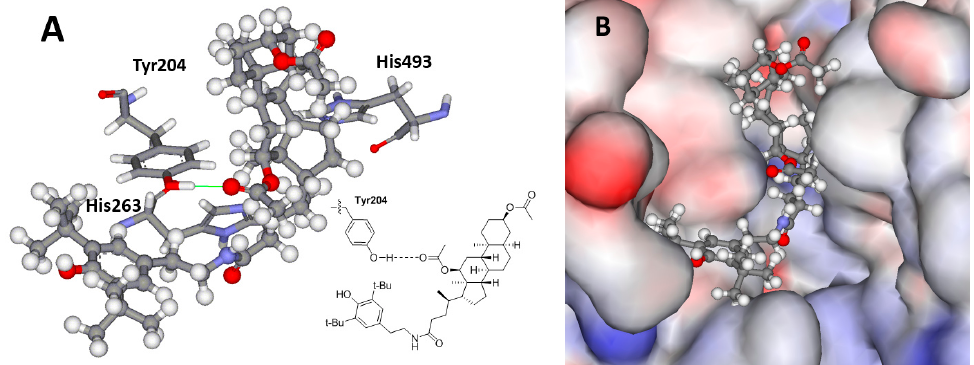
Figure 2. The docked configuration of 9a to the binding site of Tdp1 using the ChemPLP scoring function. ( A ) Hydrogen bond is depicted as a green line between the ligand and the amino acid TYR204. ( B ) The protein surface is rendered. The steroid group is inserted in a lipophilic pocket and the acyl groups are exposed to the water environment. Red depicts a positive partial charge on the surface, blue depicts a negative partial charge and grey shows the neutral/lipophilic areas.